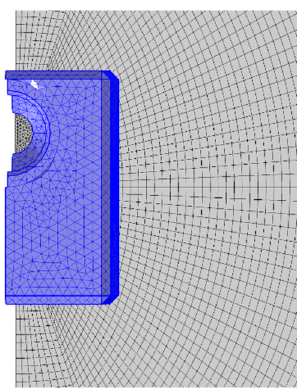
Figure 5. Picture showing the symmetry condition imposed on the transducer and on the plate, highlighted in blue.